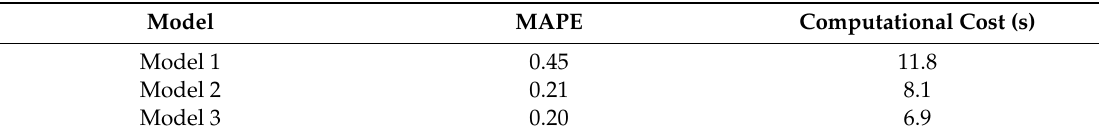
Table 6. Assessing the impact of diagnostic features on prediction performance. The first model uses all extracted features, Model 2 and Model 3 are use the features with total score higher than 1 and 1.5 respectively as training input.